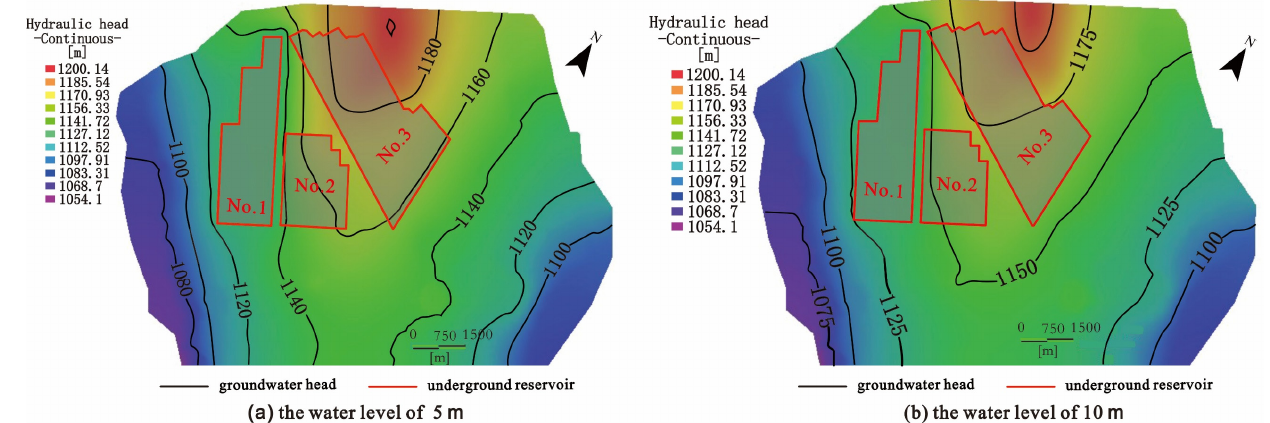
Figure 18. Groundwater contour map of the lower aquifer system for different impoundment heights of the underground reservoir: ( a ) 5 m, ( b ) 10 m.